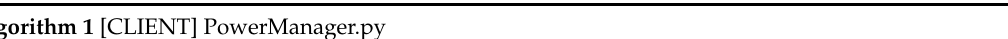
Algorithm 1 [CLIENT] PowerManager.py